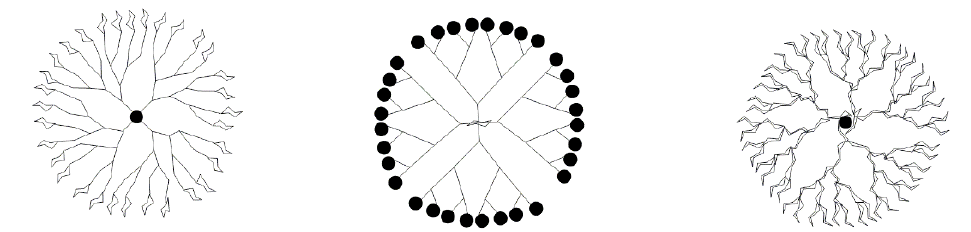
Figure 4. Different types of glyco-dendrimers.